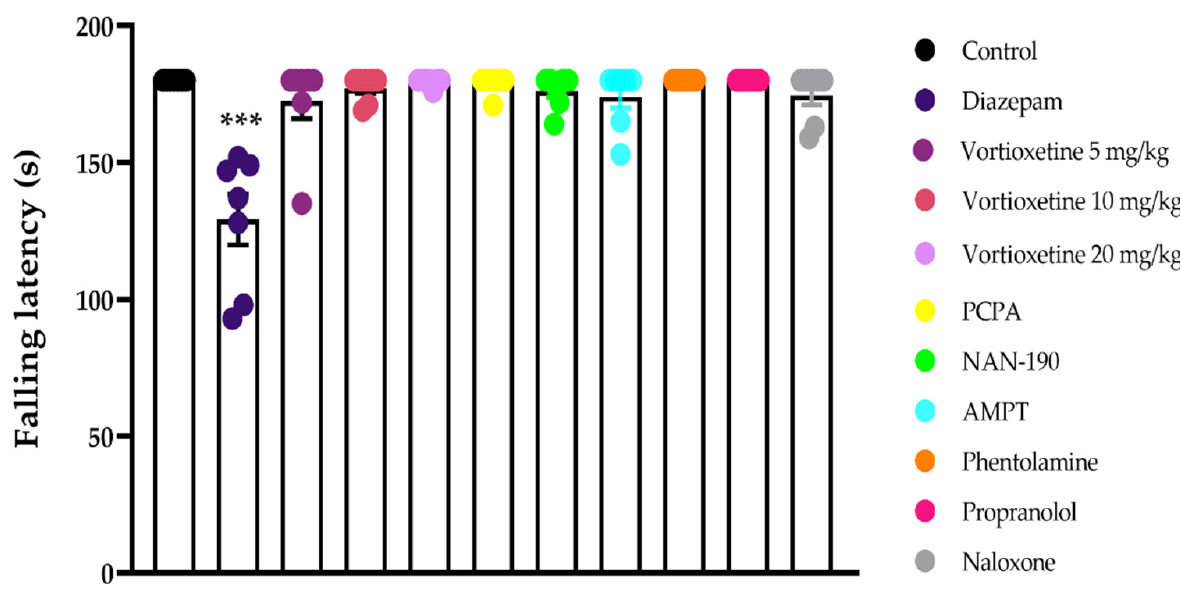
Figure 1. The effects of diazepam (2 mg/kg, p.o. ), vortioxetine (5, 10 and 20 mg/kg, p.o. ), PCPA (100 mg/kg, 4 day, i.p. ), NAN-190 (0.5 mg/kg, i.p. ), AMPT (100 mg/kg, i.p. ), phentolamine (4 mg/kg, i.p. ), propranolol (2 mg/kg, i.p. ), and naloxone (5.48 mg/kg, i.p. ) administrations on motor coordination parameters of mice in the Rota-Rod Test. Significant difference against control group *** p < 0.001, One way ANOVA, post-hoc Tukey test, n =